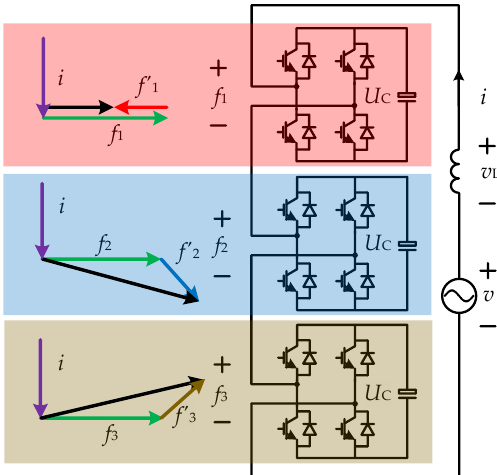
Figure 7. Vector graphs for modules considering additional fundamental components in output voltage.